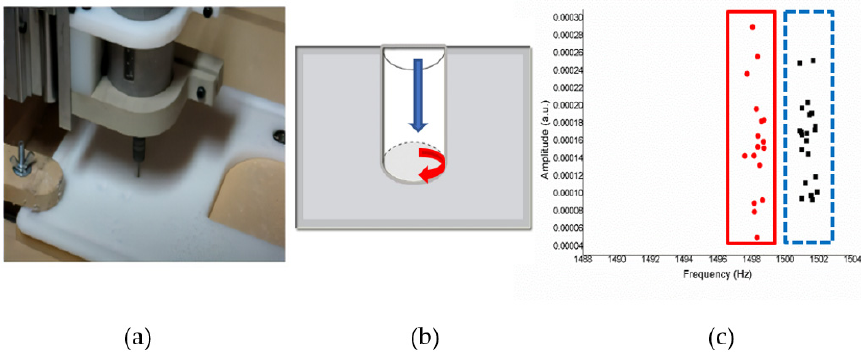
Figure 19. ( a ) Operation sketch, ( b ) trajectory of tool, ( c ) frequency of milling process for plastic material.